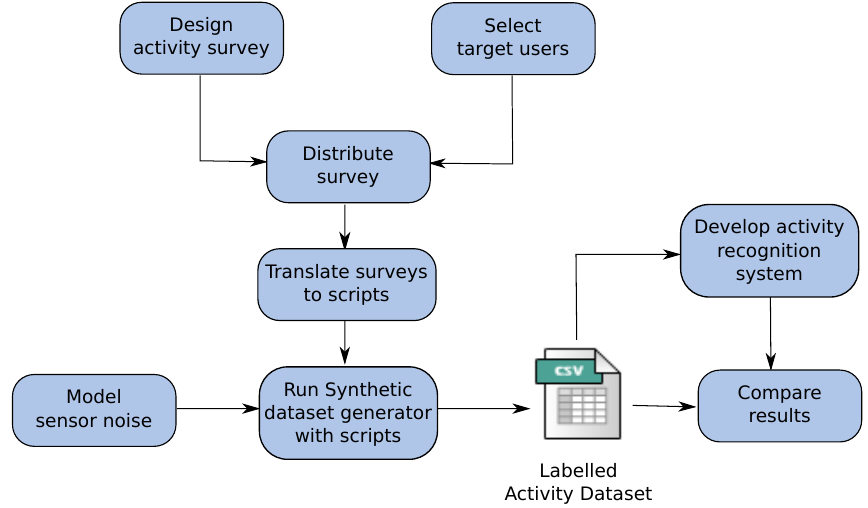
Figure 1. The hybrid evaluation methodology steps depicted in a